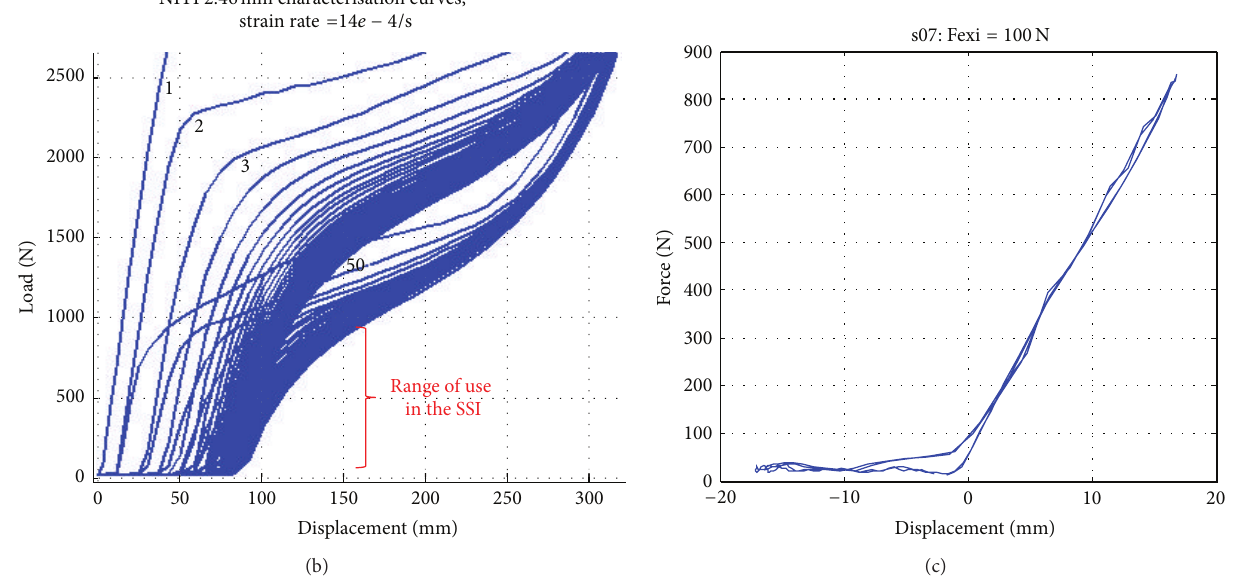
Figure 3: (a) SMA characterisation setup; (b) SMA training curve; (c) SMA behaviour during a cable dynamic